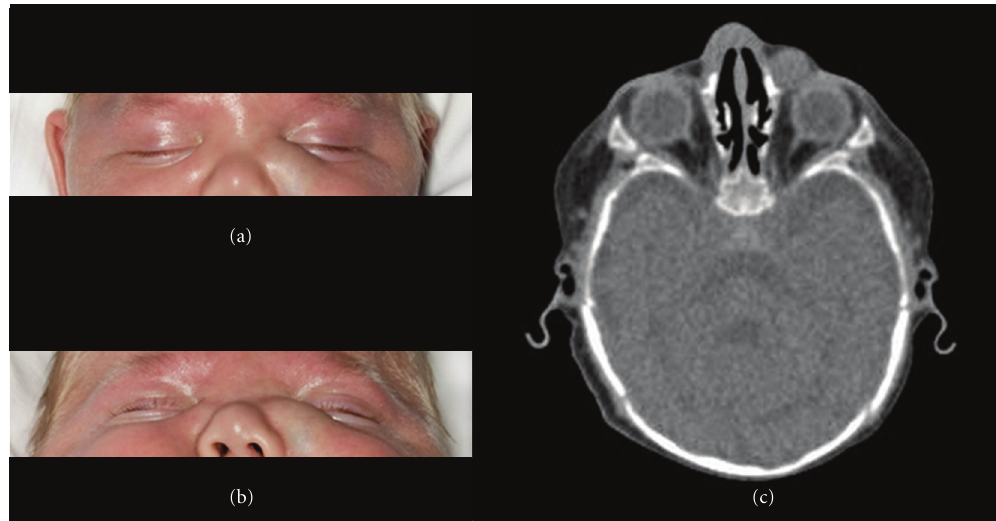
Figure 2: (a) and (b) Nonerythematous, bluish lesion 1.5 × 1.0 cm below the nasal lower lid. (c) CT scan showing 11 × 9 mm lesion along left nasocanthal